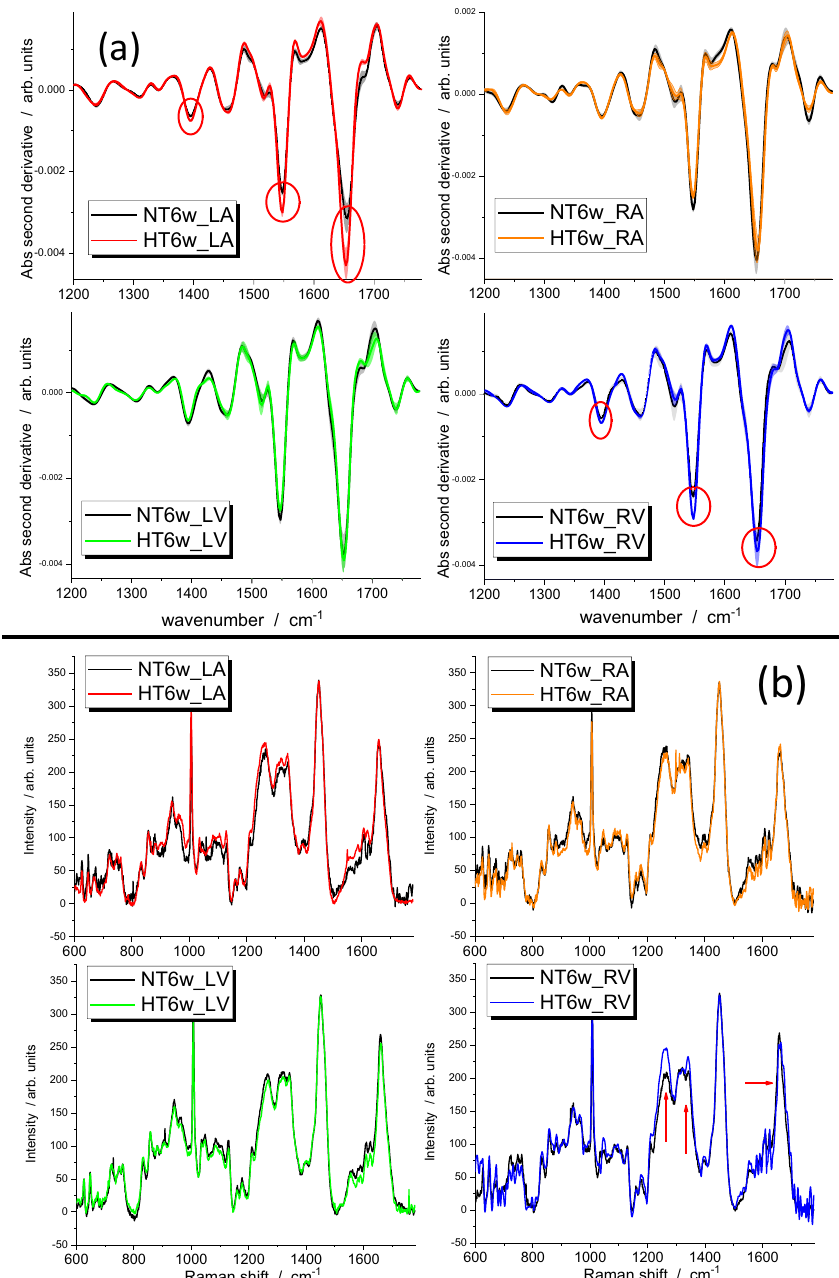
Figure 3. ( a ) Second-derivative FTIR spectra of the four heart chambers of normotensive and hypertensive (six-week, 6w) rats. Significant differences due to the pathological condition are shown by the red circles. ( b ) Raman spectra of the four heart chambers of normotensive and hypertensive (6w) rats. Red arrows indicate significant changes between the spectra of HT and NT samples. NT indicates normotensive Dahl/SS rat; HT, hypertensive Dahl/SS rat; LV, left ventricle; RV, right ventricle; LA, left atrium; and RA, right